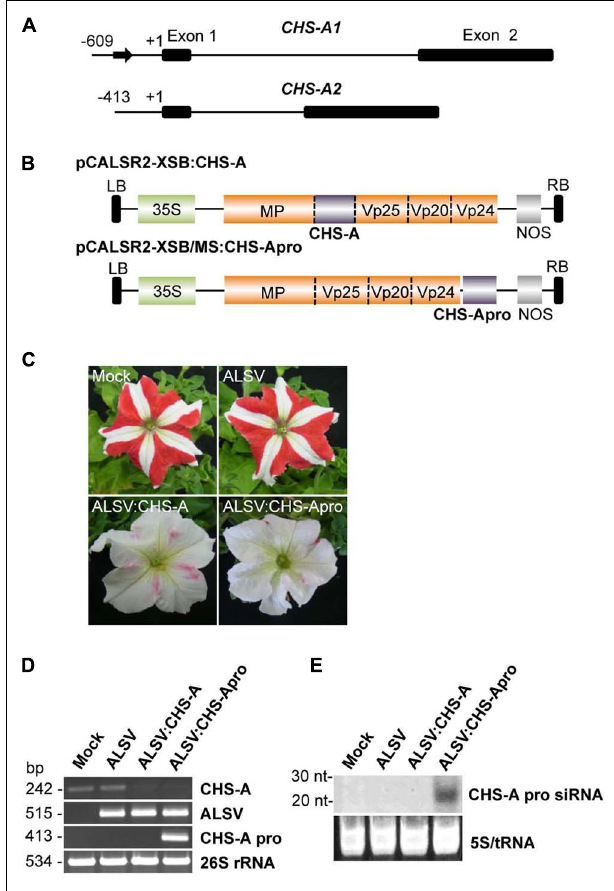
FIGURE 5 | Induction ofTGS byALSV vector carrying an endogenous petunia gene. (A) The structure of the CHS-A genes.The sequence described by Morita etal. (2012) is in the DDBJ/EMBL/GenBank database under the accession number AB678719. Arrow indicates a transposon-like 179-bp insertion fragment in the CHS-A1 promoter region. Nucleotide numbering is relative to the transcription start site. (B) Schematic representation of ALSV vectors forVIGS (pCALSR2-XSB:CHS-A) andVITGS (pCALSR2-XSB/MS:CHS-Apro) of CHS-A genes. (C) Petunia flower color phenotypes. Petunia cv. Red Star plants agroinoculated with empty vector (Mock), pCALSR1 + pCALSR2-XSB (ALSV), pCALSR1 + pCALSR2-XSB:CHS-A (ALSV:CHS-A), or pCALSR1 + pCALSR2-XSB/ MS:CHS-Apro (ALSV:CHS-Apro). (D) Analysis of mRNAs in agroinoculated petunia plants by RT-PCR.Total RNA was extracted from plants agroinoculated with empty vector (Mock), ALSV, ALSV:CHS-A, and ALSV:CHS-Apro.The 26S rRNA was amplified by PCR as an internal control. (E) Northern blot analysis of siRNAs corresponding to the CHS-A promoter gene.Total RNA was extracted from plants agroinoculated with empty vector (Mock), ALSV, ALSV:CHS-A, or ALSV:CHS-Apro and hybridized with a sense DIG-labeled RNA probe for the CHS-A promoter.The 5S rRNA and tRNA were stained by ethidium bromide and are shown as a loading